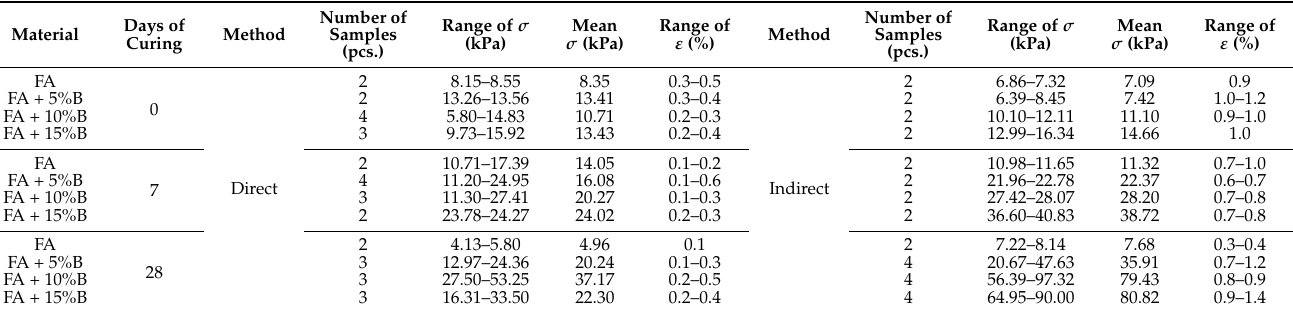
Table 3. Mean values of tensile strength of the tested